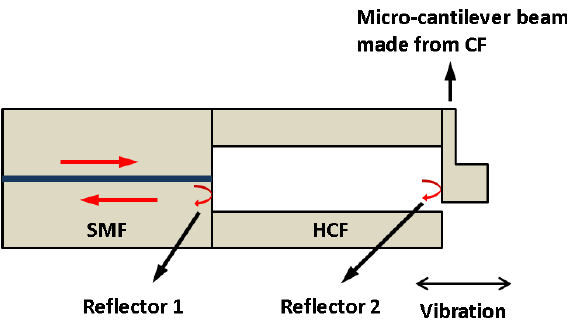
Figure 1: Schematic of the proposed on-fiber EFPI vibration sensor